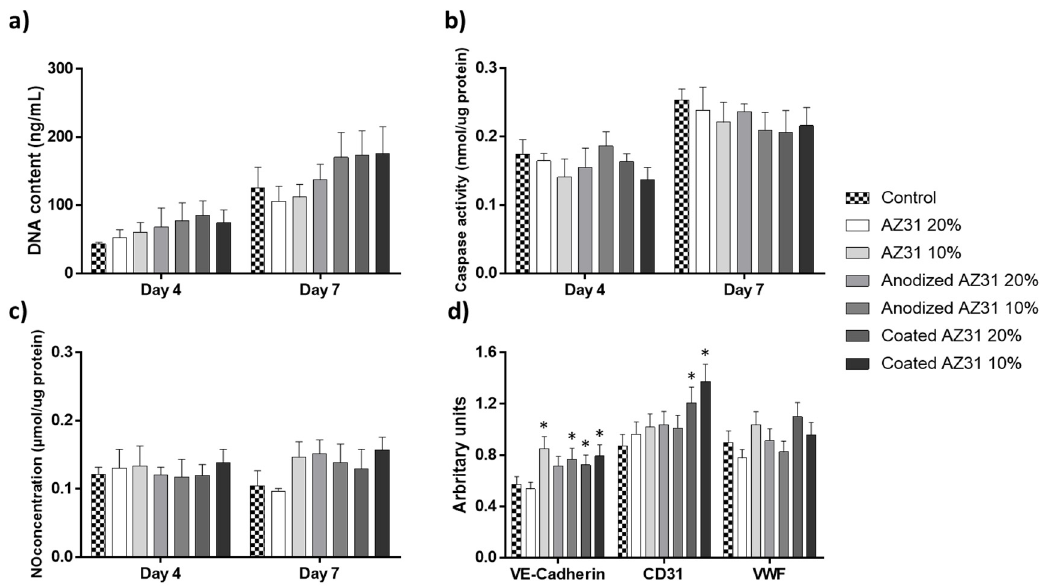
Figure 3. DNA content ( a ), Caspase-3 activity ( b ), NO concentration ( c ), and gene expression ( d ) of HUVECs cultured in the presence of the extracts from Mg-based materials and 20% and 10% dilu- tions, at days 4 and 7. * Significantly different from control (absence of the extracts).